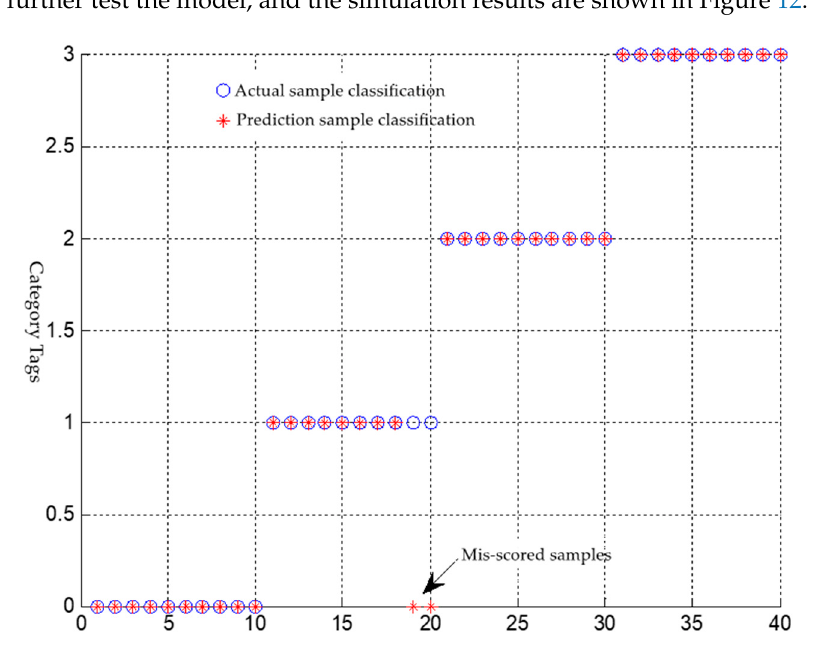
Figure 12. All sample prediction classification results.